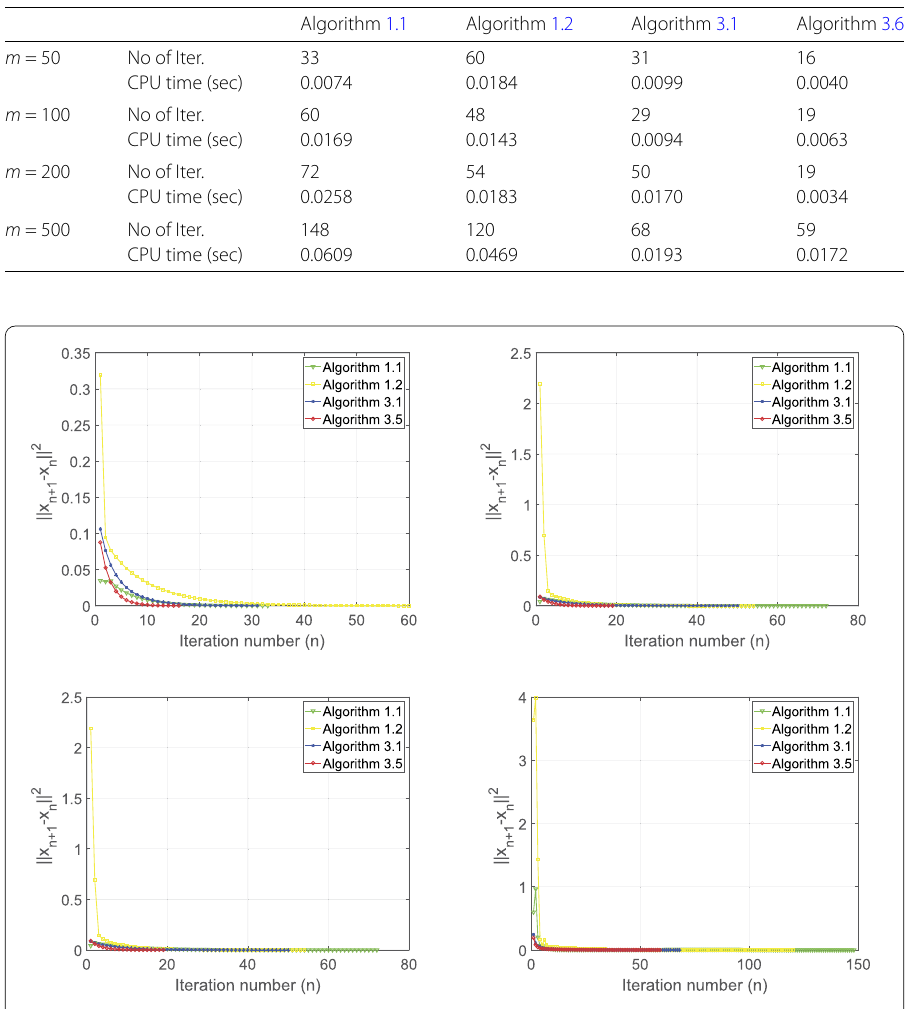
Figure 1 Example 4.1, top left: m = 50; top right: m = 100, bottom left: m = 200; bottom right: m =